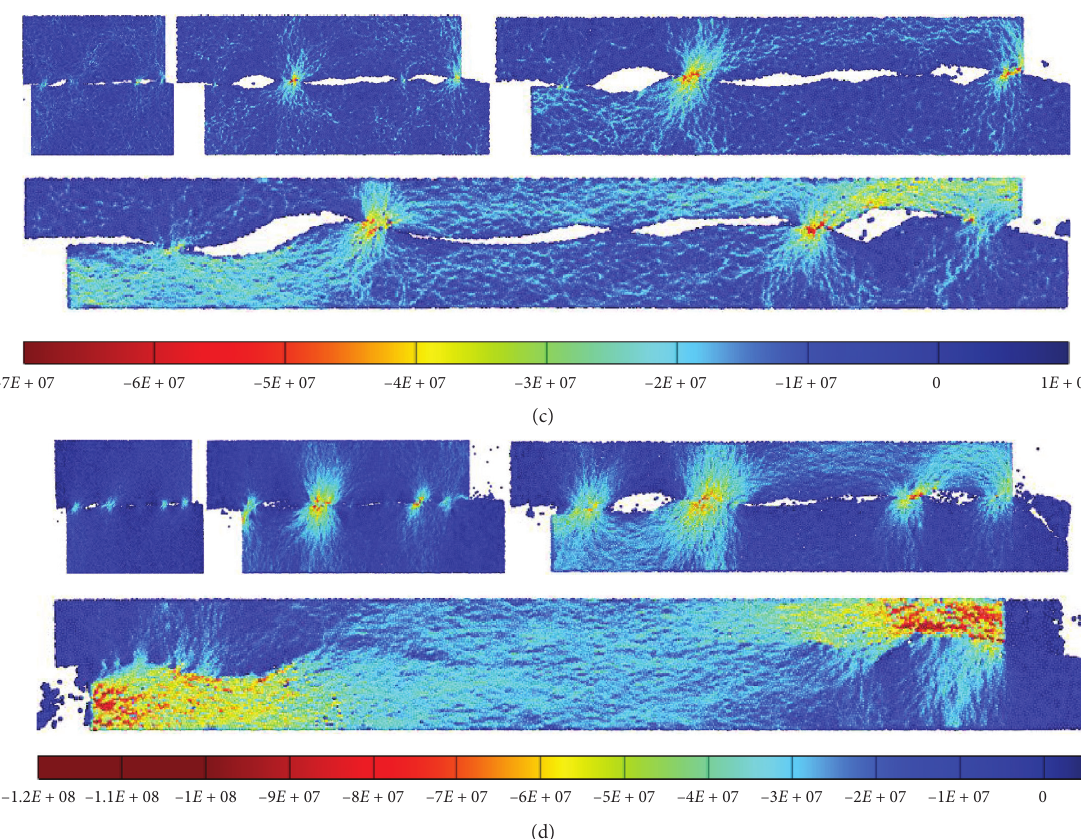
Figure 13: Maximum principal stress for repeated and enlarged joints in shear tests under CNL condition. (a) Repeated joints sheared under normal stress of 10% UCS. (b) Repeated joints sheared under normal stress of 50% UCS. (c) Enlarged joints sheared under normal stress of 10% UCS. (d) Enlarged joints sheared under normal stress of 50%